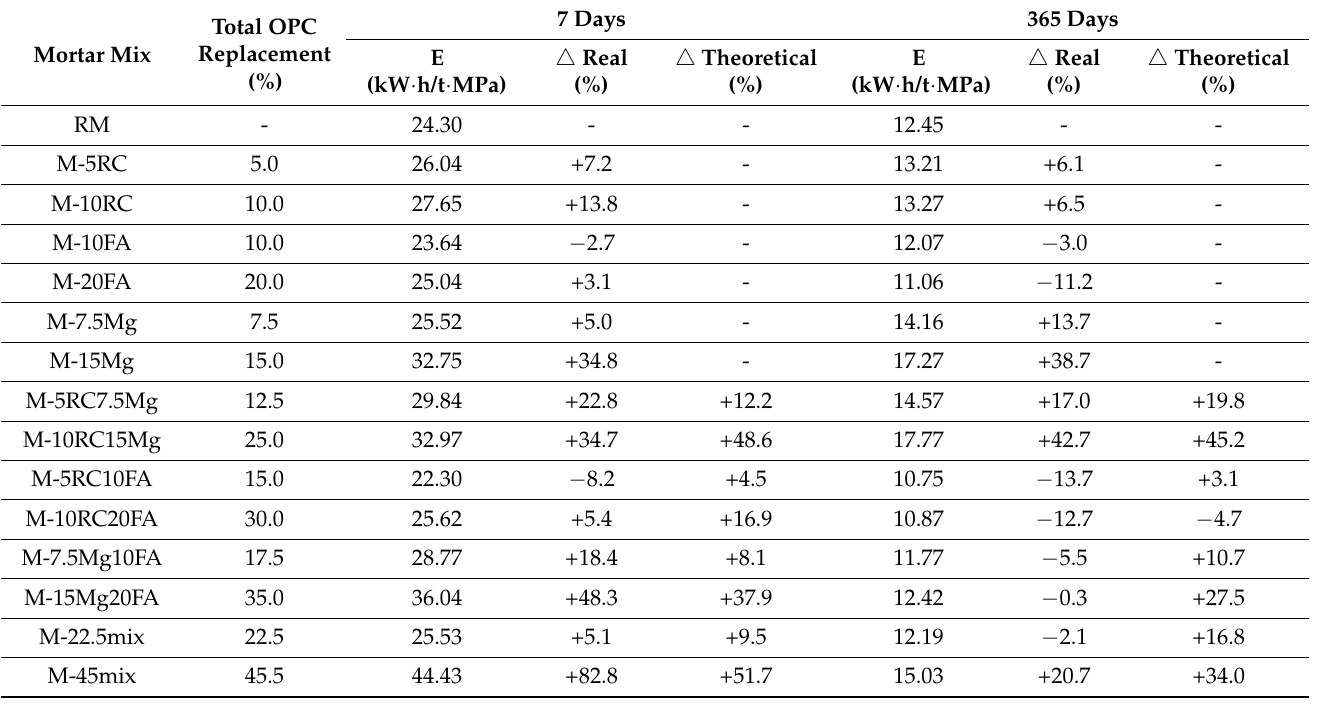
Table 11. Energy performance at 7 days and 365 days of